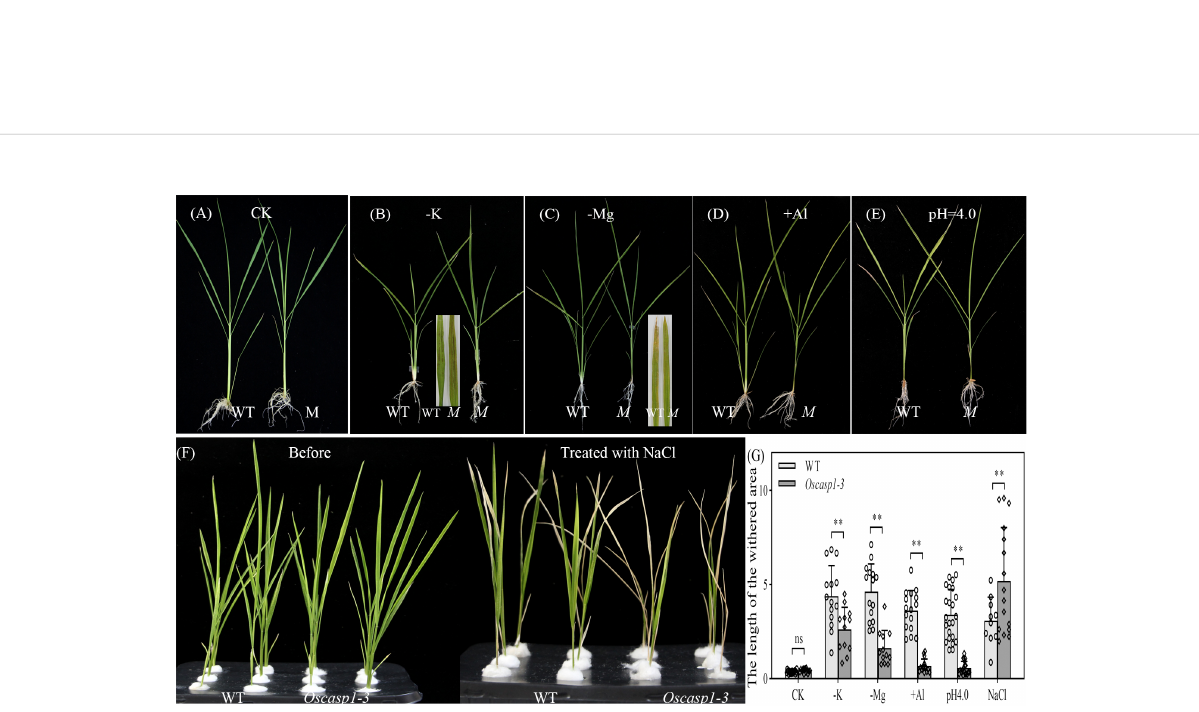
FIGURE 10 Phenotypes of WT and Oscasp1-3 mutant plants grown in various media with elemental mineral imbalances. (A) In complete medium. (B) In medium without potassium. (C) In medium without magnesium. (D) In medium with 100 µM AlCl 3 . (E) In medium with a low pH value (pH = 4.0). (F) In medium with 100 mM NaCl. (G) The length of the withered leaf area of these seedlings grown in various media. Student ’ s T-test was used for statistical analysis, and ** represents statistically signi fi cant difference (p value < 0.01); ns: no signi fi cance. M: Oscasp1-3 .